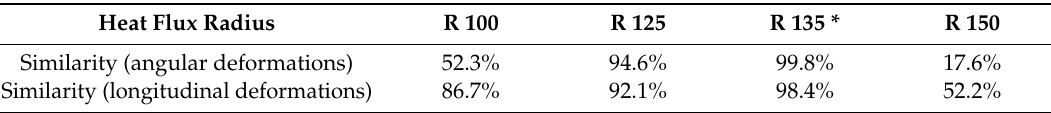
Table 4. Agreement test for experimental and analysis results (specimen